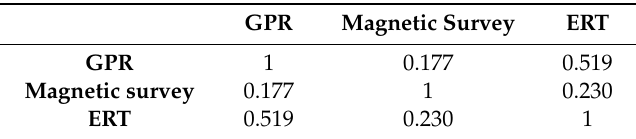
Table 3. Pearson correlation coe ffi cient.